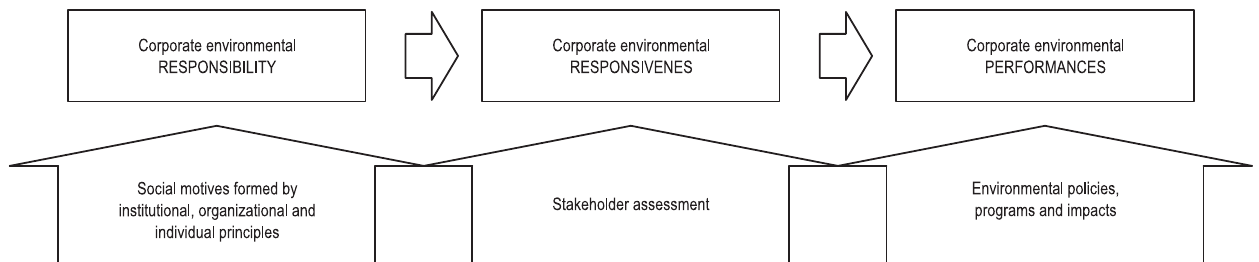
Fig 1. The conceptualisation of corporate environmental responsibility, responsiveness and performances (adopted from